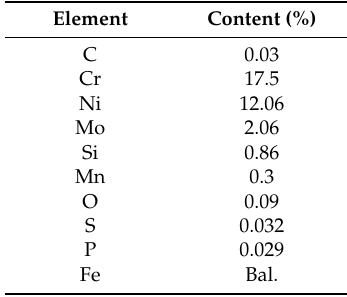
Table 2. SLM processing parameters of 316L steel